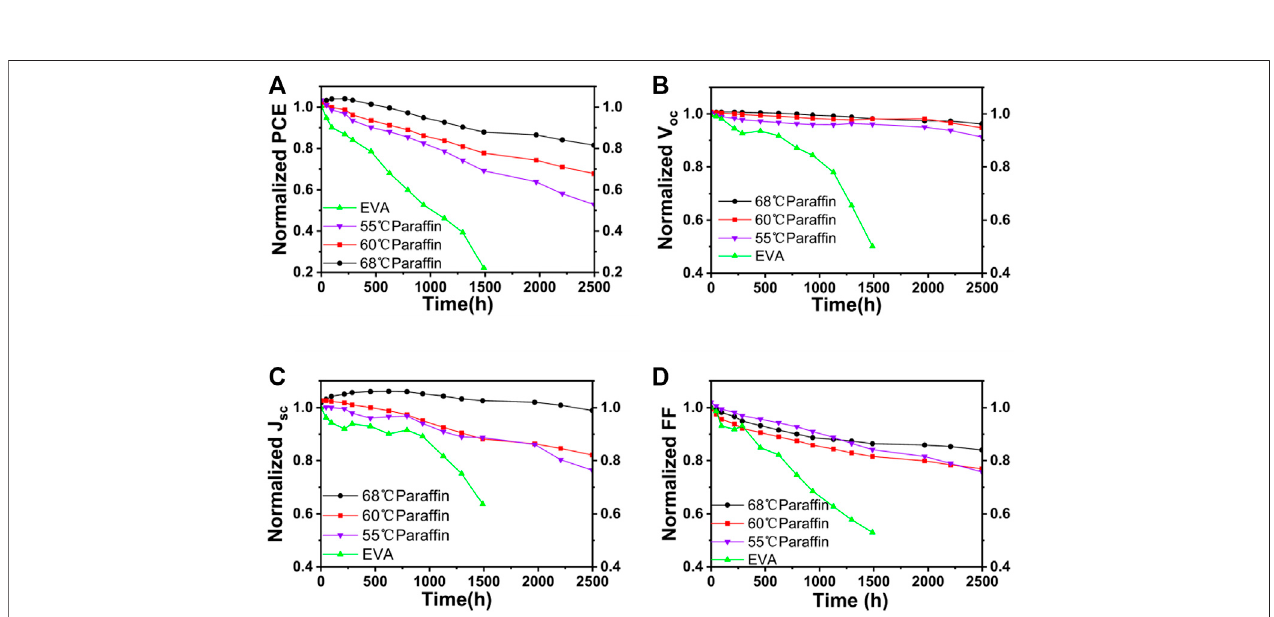
FIGURE 6 | Long-term stability of PSCs encapsulated with paraf fi n/EVA/paraf fi n with different melting points paraf fi n at 75% RH and room temperature (A) . Evolution of photovoltaic parameters of PSC encapsulated by different melting points paraf fi n for V OC (B) , J SC (C) and FF (D) .